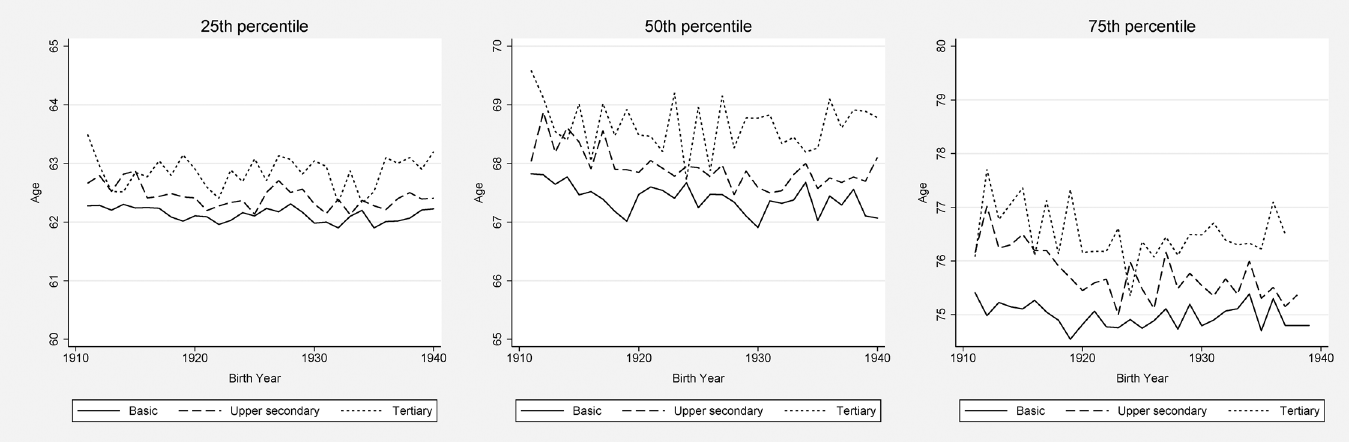
Fig 4. Hospitalization by education, women. Age at which 25, 50 (i.e., median age of death), and 75% of the study population had been admitted to